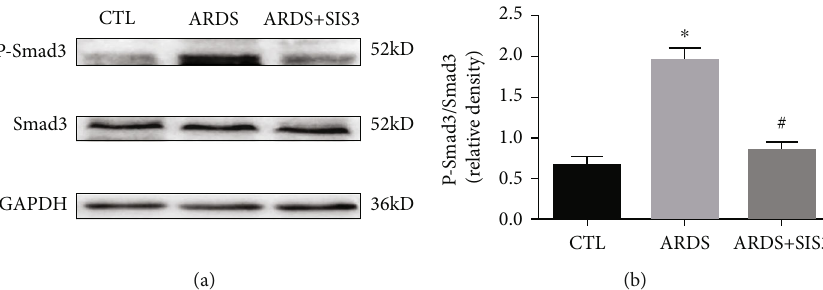
Figure 7: Phosphorylation of smad3 was inhibited by SIS3 in the lung tissue of ARDS rats. The activation of Smad3 was evaluated using western blotting analysis, and the amount of phospho-Smad3 formed was analyzed 24h after treatment with either LPS or PBS. GAPDH was used as the loading control. The data are presented as the means ± SD ( n = 10 ). ★ P < 0 : 05 vs. CTL; # P < 0 : 05 vs.